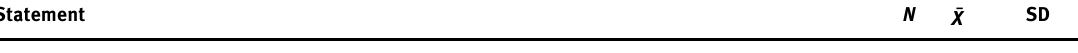
Table 3: Speed in relation to assessment and training